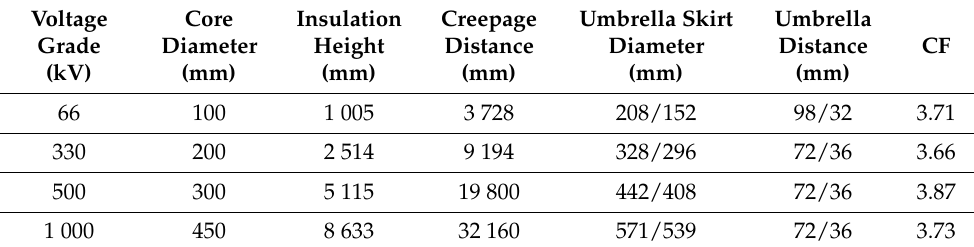
Figure 1. Schematic of sample structure. 1—structure height; 2—insulation distance; 3—shed spacing; 4—core diameter; 5—big shed distance; 6—small shed distance. Table 1. Composite crossarm insulator parameters.